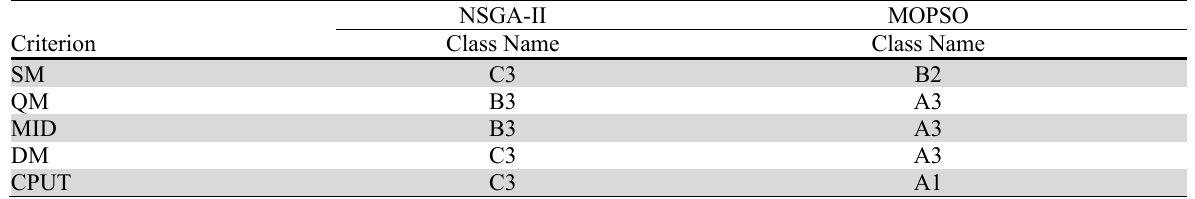
The best classes achieved by Mean value and Standard Error for small scale sample problems